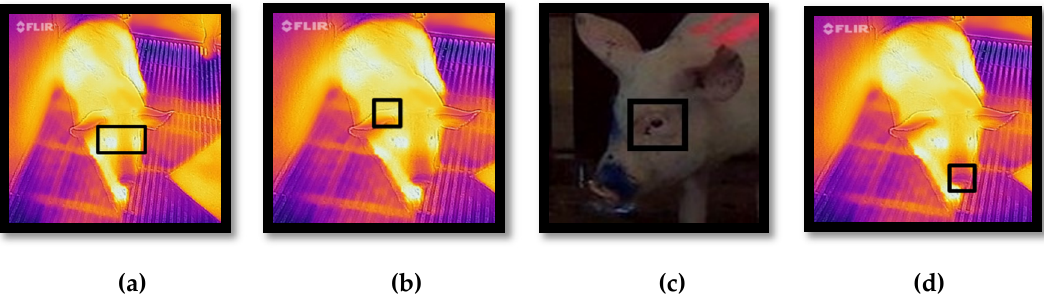
Figure 1. Regions of interest (ROIs) for image processing; ( a ) eye area (for eye-temperature), ( b ) base of ear (for ear-base temperature), ( c ) eye area (for heart rate) and ( d ) nose area (for respiration rate).